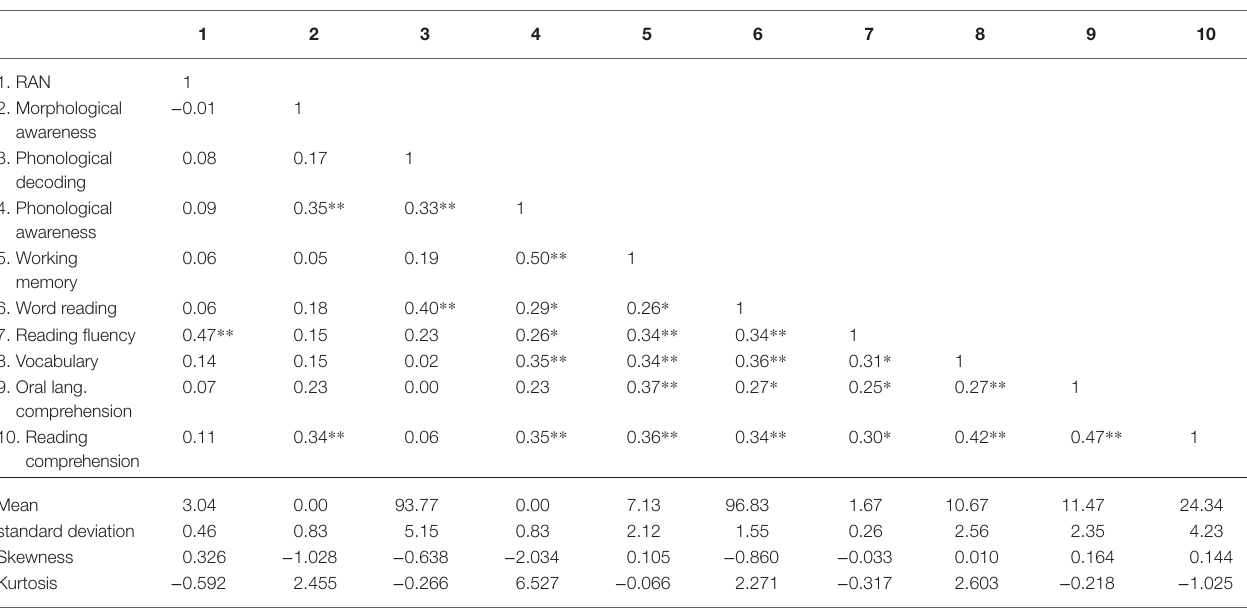
TABLE 1 | Correlation matrix (Pearson product–moment correlation coefficients) and descriptive